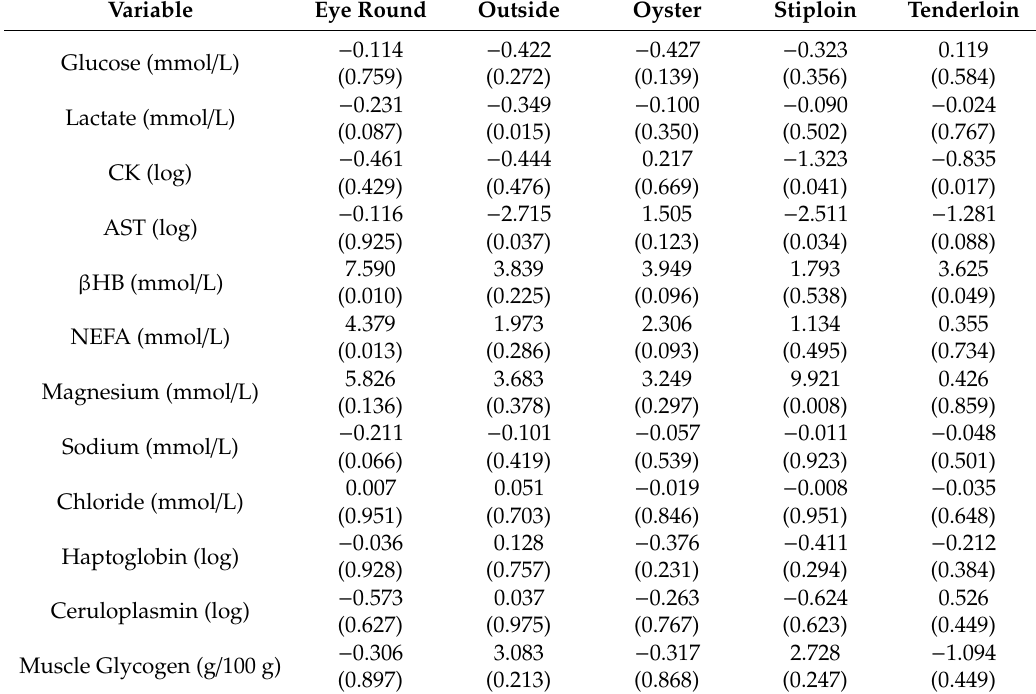
Table 2. Coe ffi cient estimates for plasma with meat quality score (MQ4) for five diferent muscles in all cattle, King Island and Tasmania. P value is in brackets. Coe ffi cients with p -values less than 0.1 are highlighted are in